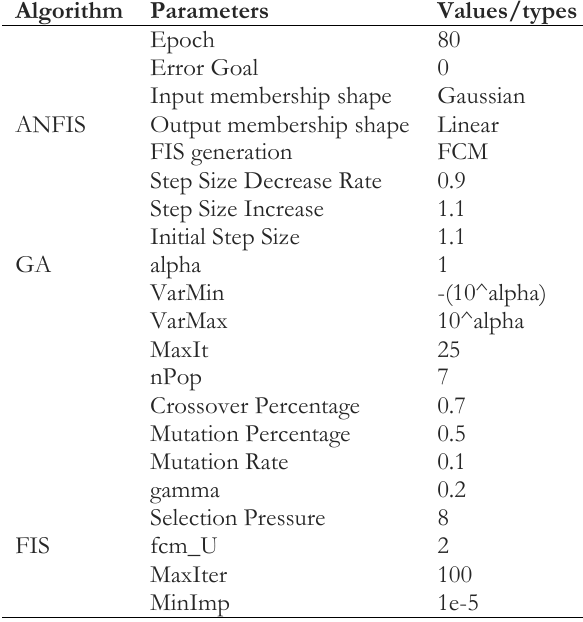
Table 1. Initial parameters